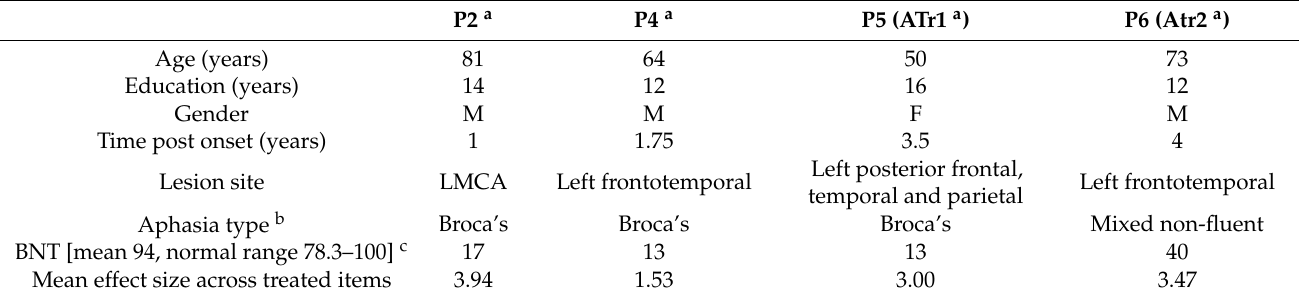
Table 1. Participant characteristics and scores (percent correct) on background tests for patients with